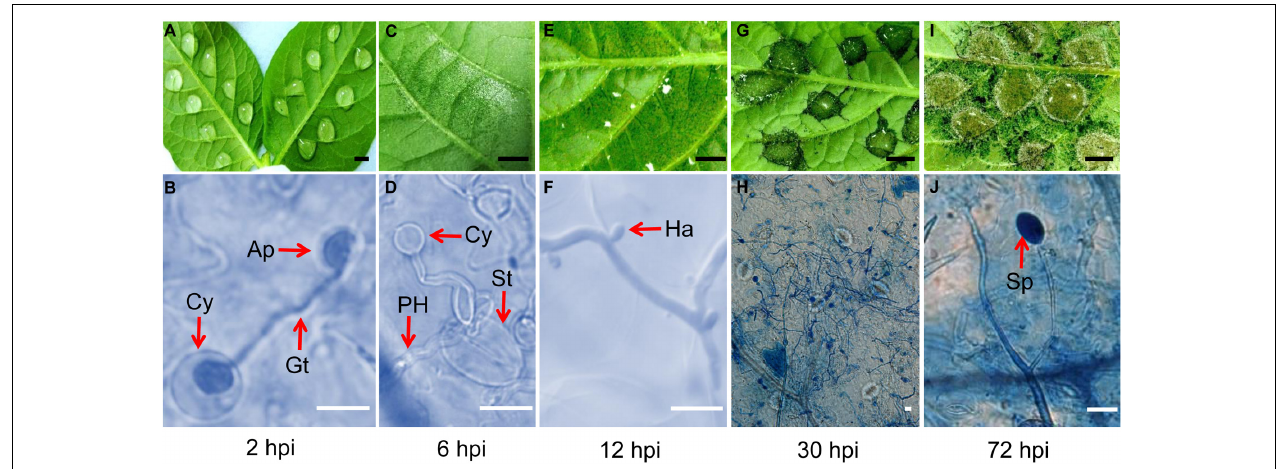
FIGURE 2 | The ideal sampling time point of potato infection by P. infestans was confirmed by observation. (A,B) At 2 h post inoculation (hpi), the Cy (cyst) germinated and extended out Gt (germ tube) to form Ap (appressorium) and was ready to invade into host cells. (C,D) At 6 hpi, some pathogen PH (primary hyphae) invaded into host through the host St (stoma), and developed inside the host. (E,F) At 12 hpi, young hyphae broadly spread and haustoria formed, but only very small black spots could be macroscopically observed on the leaf. (G,H) At 30 hpi, the infection site turned to dark and obvious damage could be observed. (I,J) At 72 hpi, air hyphae appeared and young Sp (sporangium) was ready to form. (Black bar, 0.5 cm; white bar, 10 µ m).